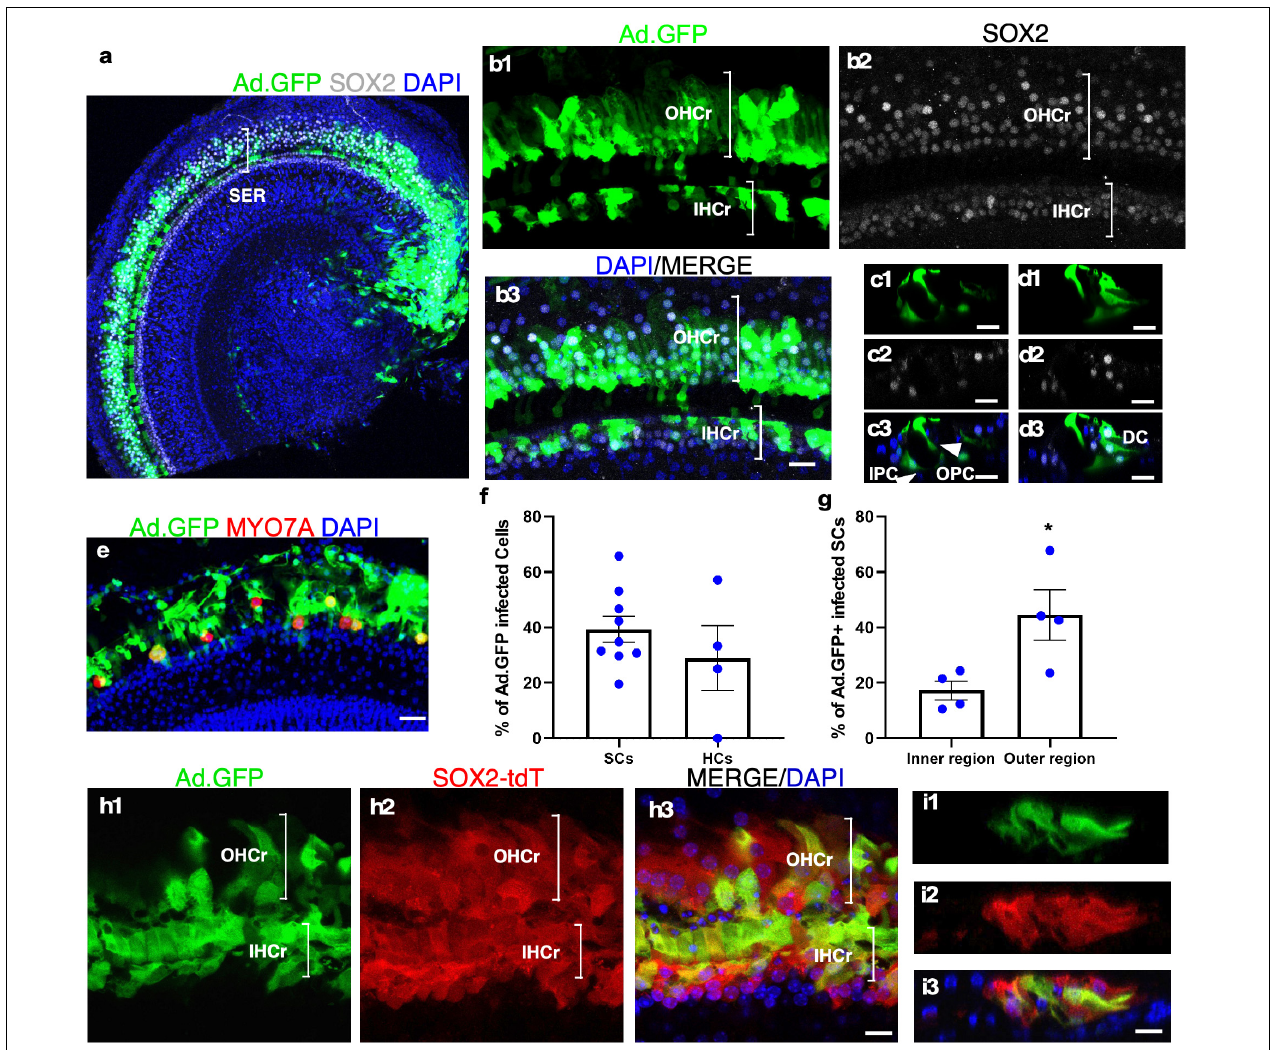
FIGURE 4 | Adenovirus infects cultured adult SC subtypes and IHCs. (a) A surface view of a cultured adult cochlea (apical and part of the middle turn) infected by Ad-GFP with the production of GFP mainly in the SER with fewer infected cells in the limbus region. (b1–b3) The enlarged SER shows GFP + SCs (SOX2 + /GFP + ). (c,d) Cross-sections of the SER to show the infected SC subtypes (SOX2 + /GFP + ) according to their positions in the organ of Corti, including inner and outer pillar Cells (IPCs and OPCs), Deiters’ cells (DCs), and inner phalangeal cells (IPhCs). (e) Surviving IHCs were infected by Ad-GFP (MYO7A + /GFP + ). (f,g) Quantification and comparison of Ad-GFP-infected SCs vs. IHCs and infected SCs in the inner vs. outer SERs. (h1–h3) A lineage tracing study is shown in a cultured adult SOX2-CreER-Tm-red mouse cochlea treated by tamoxifen and infected by Ad-GFP. Tm-red and GFP were co-localized in the SCs in the sensory epithelium. (i1–i3) Cross-sections of the SER in (h) to show co-localization of Tm-red and GFP in the SCs. * p < 0.05, Student’s t -test. Error bar, mean ± SEM, n = 4–9. n is the number of biologically independent cochlea samples. Scale bars: 10 µ